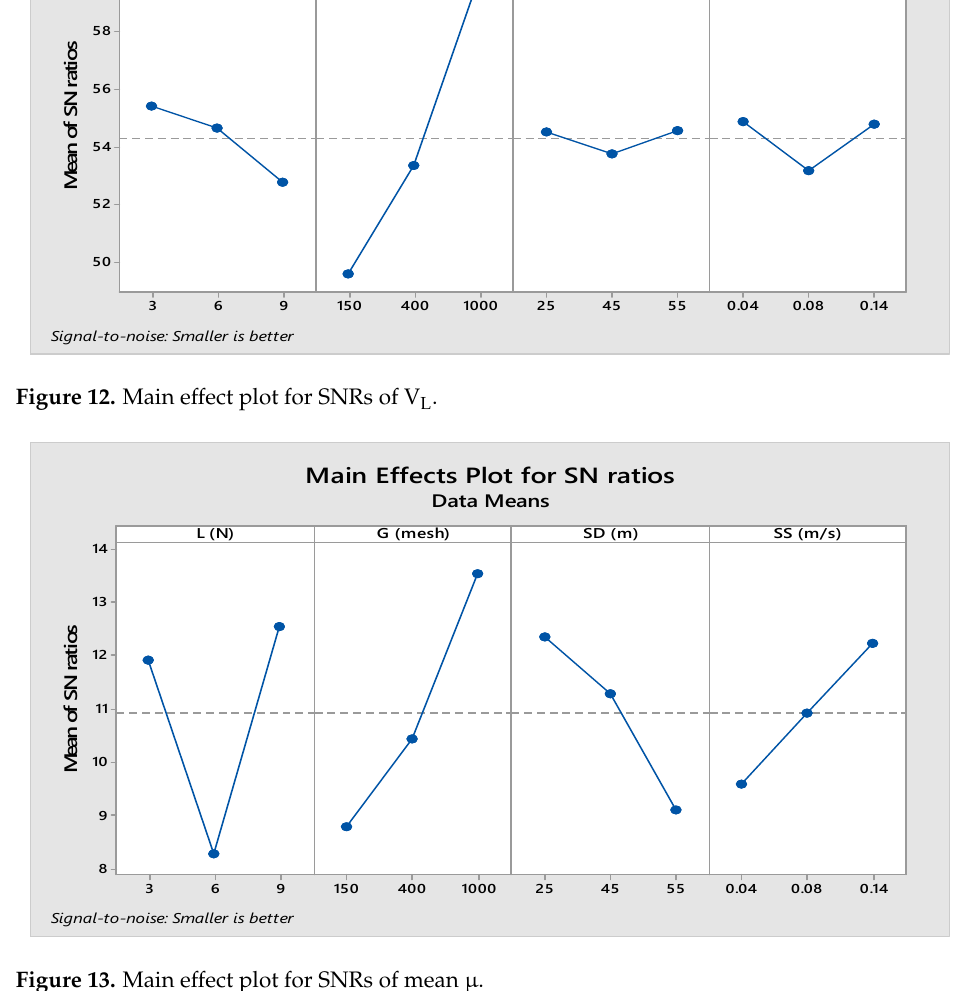
Figure 13. Main effect plot for SNRs of mean μ .